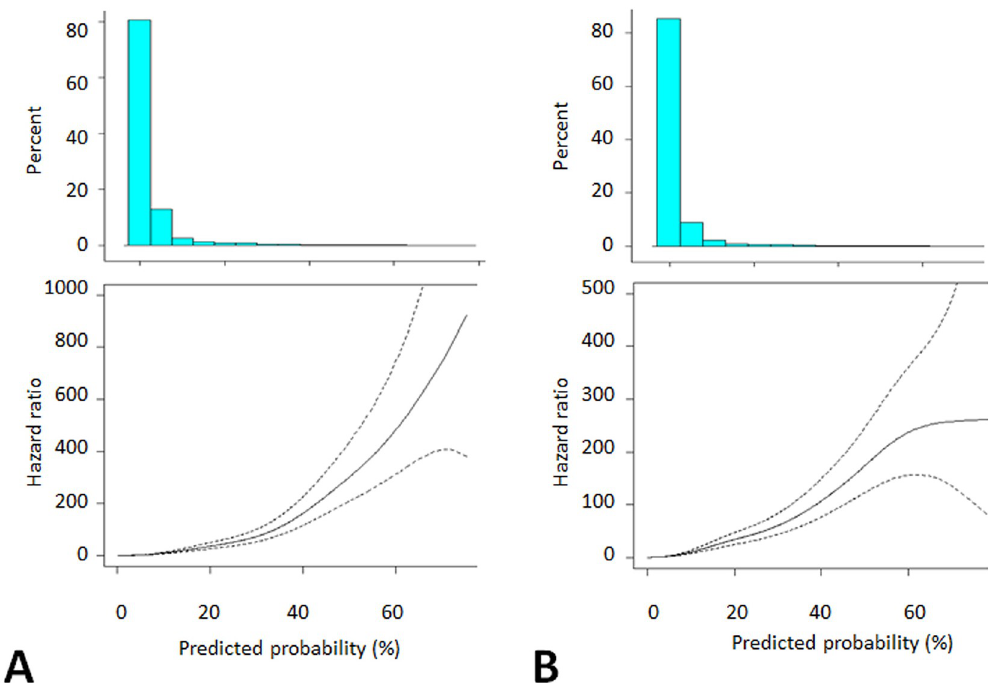
Fig 3. Relationships between risk of primary outcome and its predicted probability. Histograms of the probabilities and the hazard ratios of the primary outcome are shown in the upper and lower panels, respectively. A, RF_time_all, p < 0.0001; B, RF_time_v8, p < 0.0001. Abbreviations: HR, hazard ratio; RF, Random